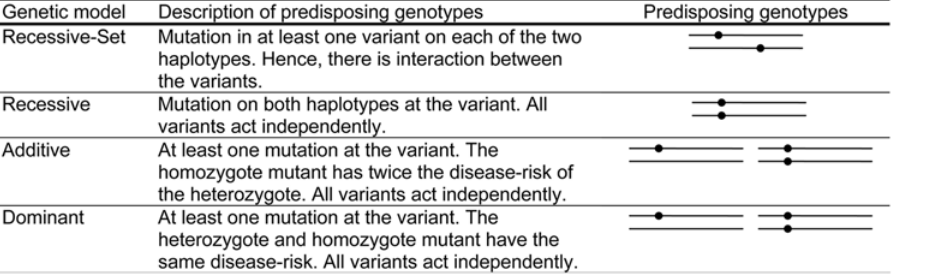
Figure 1. Genetic models. Model descriptions and examples of predisposing genotypes are shown for the genetic models used. Lines symbolise haplotypes and dots symbolise disease-risk